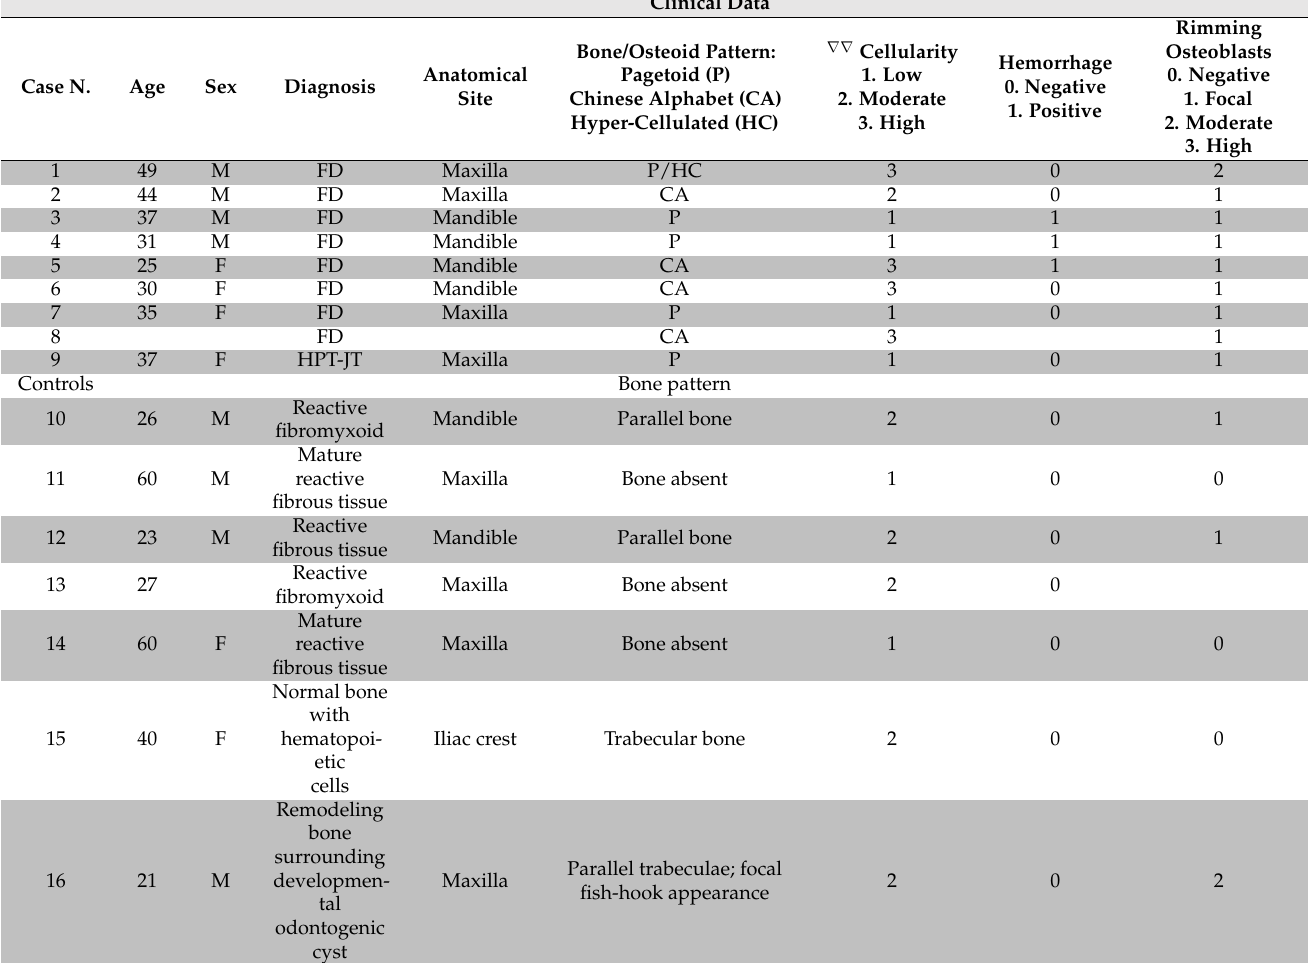
Table 1. Clinical and histopathological findings in congenital fibro-osseous lesions of the jaw com- pared to reactive fibrous-osseous lesions and normal bone. Clinical